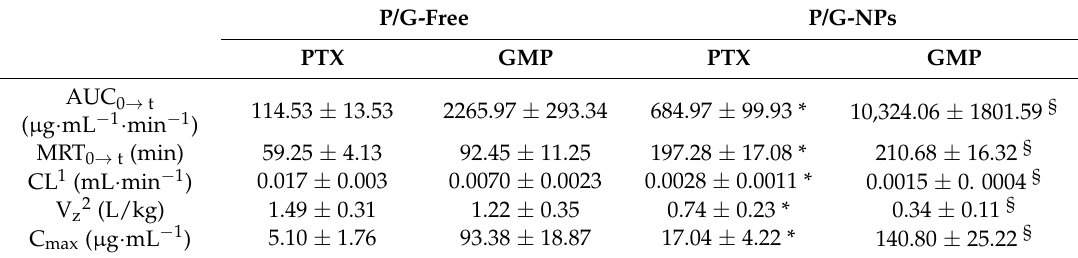
Figure 4. Blood concentration–time profiles of formulations after intravenous injection at 16 mg/kg of GMP and 2.0 mg/kg of PTX in rats ( n = 6). Table 2. Pharmacokinetic parameters of PTX and GMP in P/G-Free and P/G-NPs at a dose of 16 mg/kg for GMP and 2.0 mg/kg for PTX ( n =